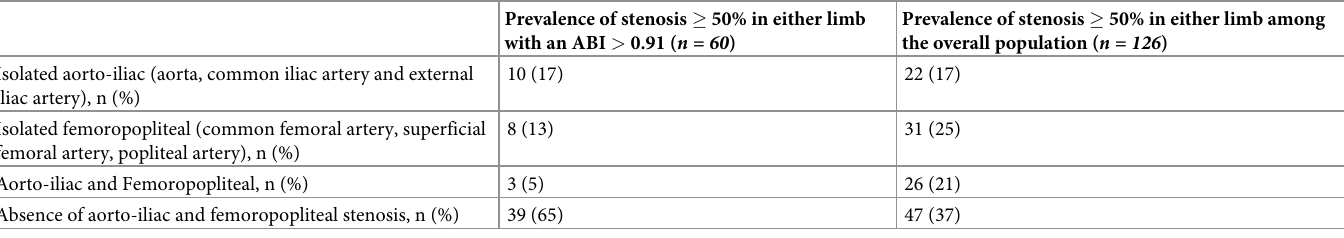
Table 2. Prevalence and anatomic level of stenosis � 50% in either